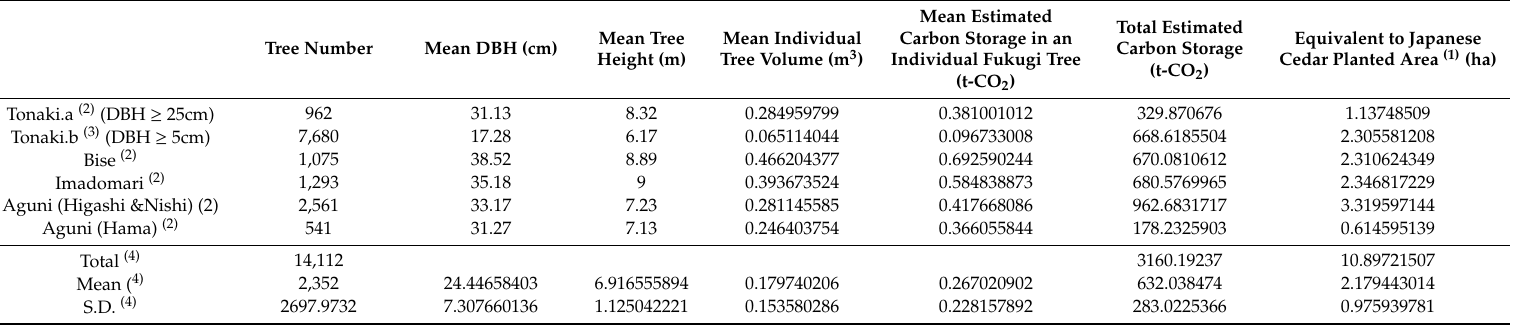
Table 3. Carbon storage estimated from tree numbers in Okinawa